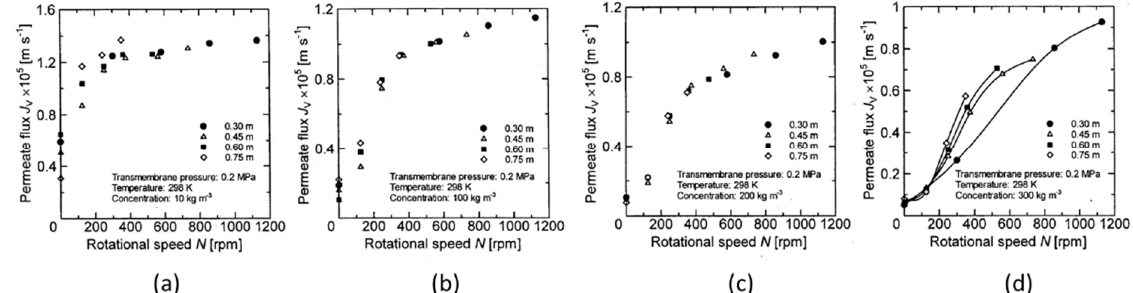
Figure 10. Relationship between rotation speed and permeate flux when the TMP is 0.2 Mpa. ( a ) at latex concentration 10 kg/m 3 ( b ) 100 kg/m 3 ( c ) 200 kg/m 3 ( d ) 300 kg/m 3 .